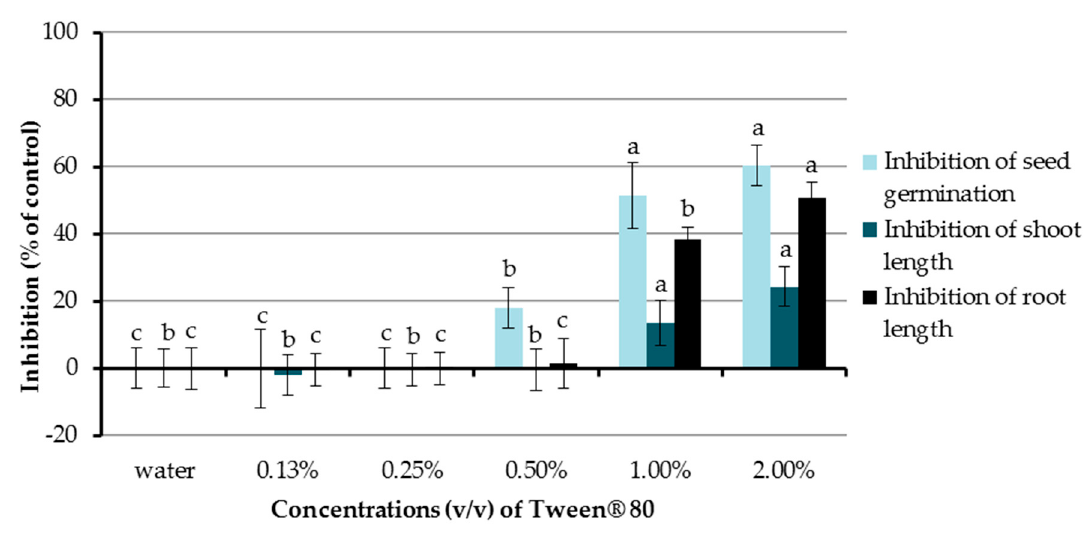
Figure 2. Effects of Tween ® 80 (at concentrations of 0.13–2.0% v / v ) on seed germination and seedling growth of Chinese amaranth. Distilled water was used as a control. Means with the same letters in the graph are not significantly different at p ≤ 0.05 level.